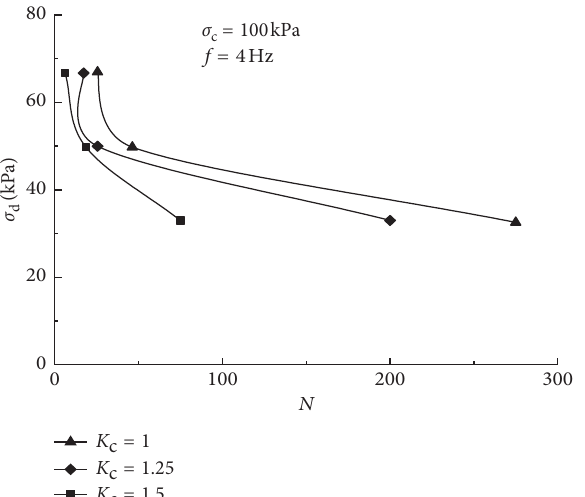
Figure 10: Dynamic strength curves of clay under different initial shear stresses.